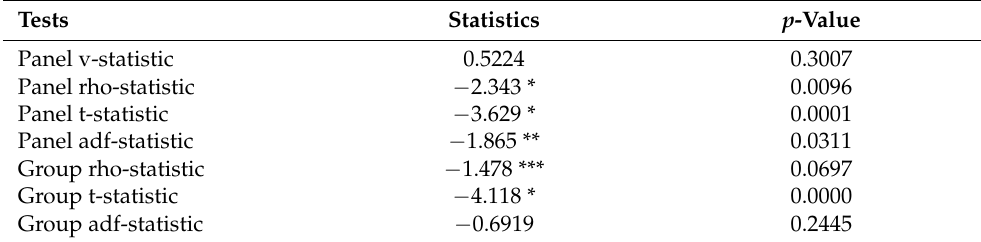
Table 3. The Pedroni cointegration